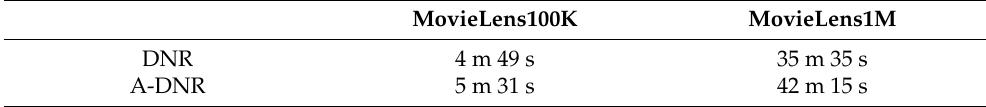
Table 4. Time cost on DNR and